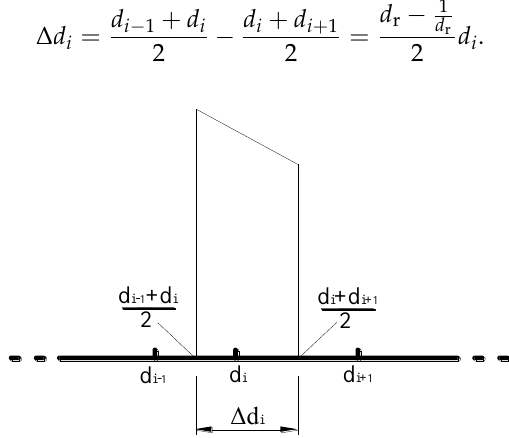
Figure 3. Schematic of distribution width of i th